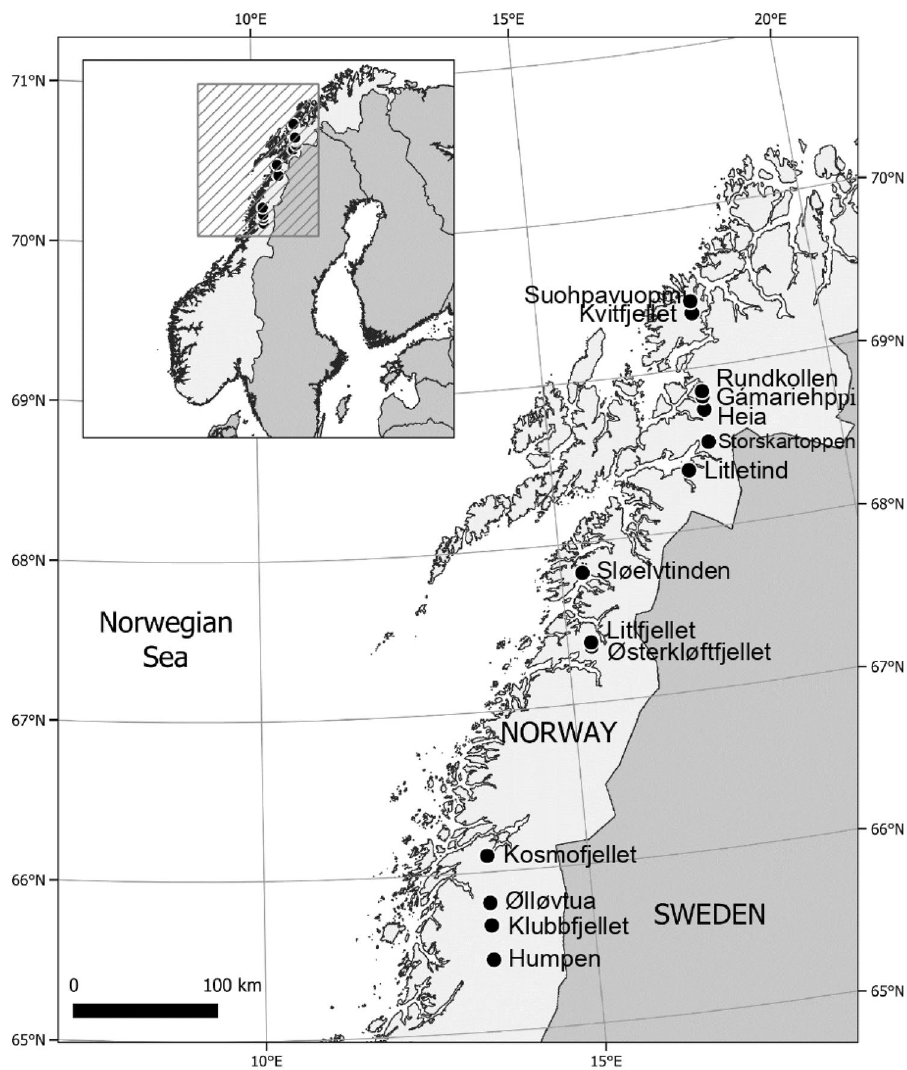
Figure 1. Map showing the 14 study sites located along a 500 km latitudinal gradient in northern